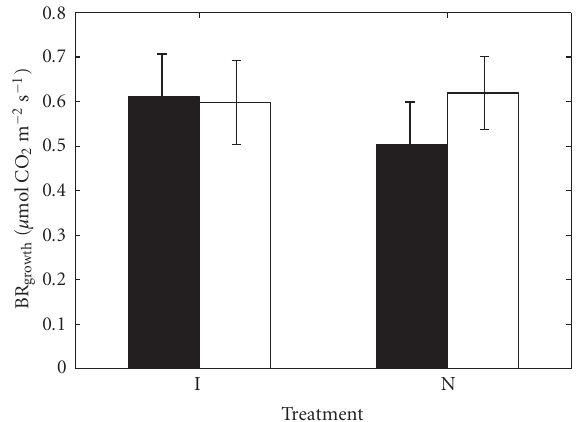
Figure 3: Weighted mean basal soil respiration (weighted using the inverse of the standard error of BR) at growth conditions (BR growth ) in inoculated pasteurized soil (I) and non-inoculated pasteurized soil (N). Black bars represent BR at 10 ◦ C for the ambient climate scenario, and white bars represent BR at 13 ◦ C for the future climate scenario (for more details, see Section 2). Error bars are the standard deviation on the weighted mean.